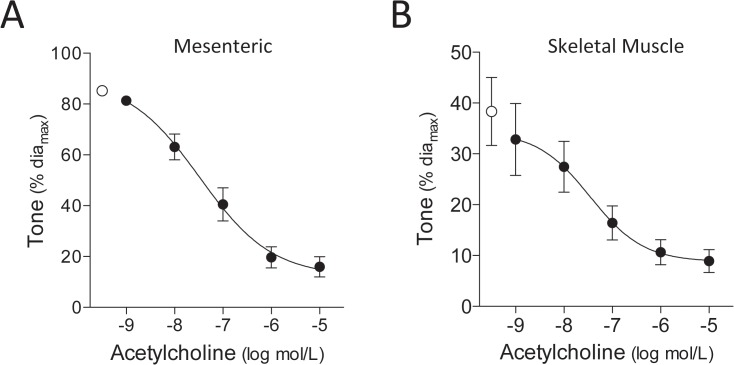
Human mesenteric and skeletal muscle resistance artery vasodilator responses.Human (A) mesenteric (n = 7 vessels from N = 3 patients) and (B) skeletal muscle (n = 8, N = 5) resistance arteries constrict in response to 10-5 mol/L phenylephrine (open circles) and dose-dependently dilate when acetylcholine is subsequently co-applied (closed circles). For mesenteric arteries: diamax = 255±23μm and logEC50 = -7.4±0.2. For skeletal muscle arteries: diamax = 133±22μm and logEC50 = -7.2±0.2. Diamax is defined as the maximal diameter (under calcium free buffer conditions) at 60mmHg.